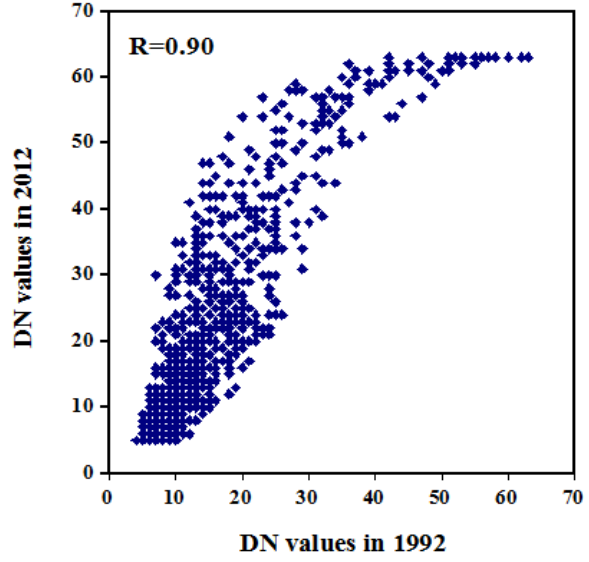
Figure 2. Correlation of DN values between 1992 and 2012 in the city of Jixi, Heilongjiang Province.